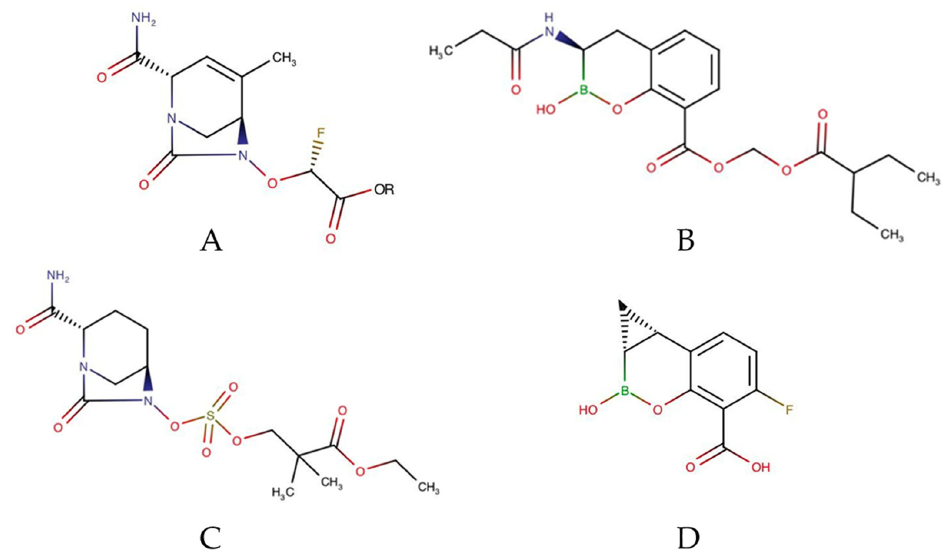
Figure 3. Chemical structures of ( A ) ETX0282, ( B ) VNRX-7145, ( C ) ARX-1796, and ( D ) QPX7728.